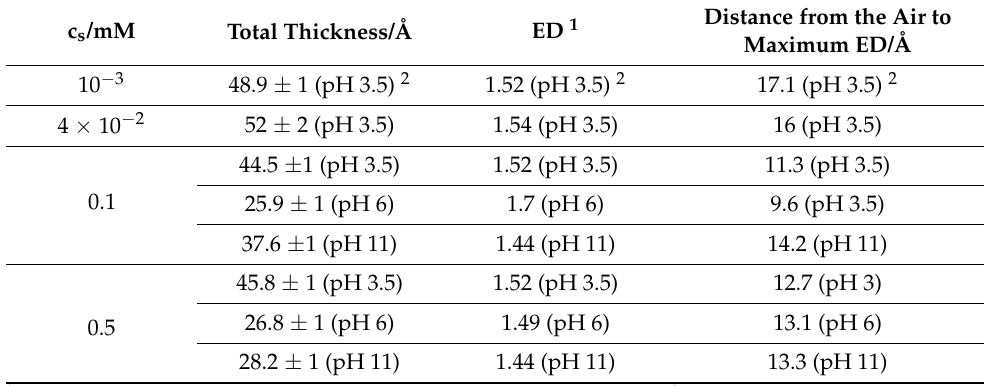
Figure 9. XRR curves for 1 mg mL − 1 PAA + 0.5 mM G12 for the three pHs studied. The red lines are the fitting curves. Table 1. Fitting results of XRR measurements of PAA-G12 mixtures at the air-solution interface.